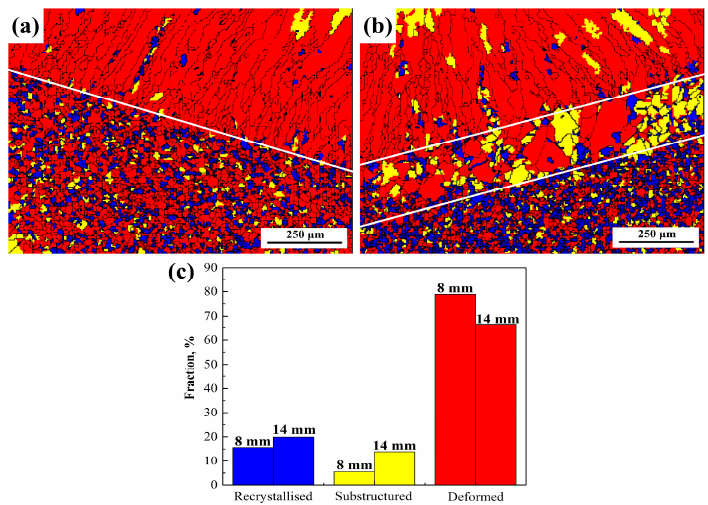
Figure 7. Recrystallised grain distribution diagram for ( a ) 1670-8 and ( b ) 1670-14, and ( c ) the fraction of grains for the di ff erent thicknesses of welded of grains for the different thicknesses of welded joints.